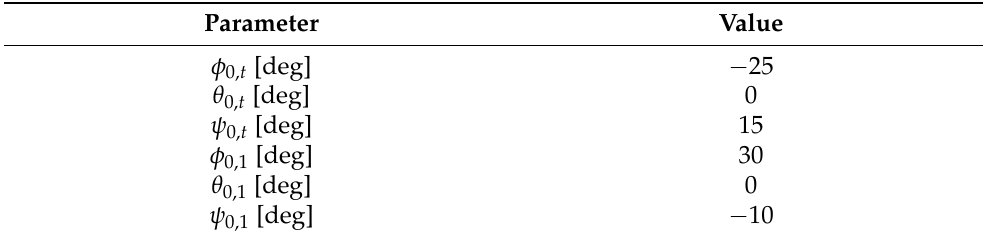
Table 3. Desired Euler angles and angle rates for the roto-translational maneuver, subscripts 1 and t denote chaser 1 and target, respectively.